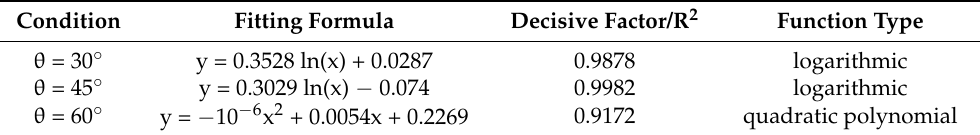
Table 5. Cumulative displacement fitting function for variable initial tension angles.